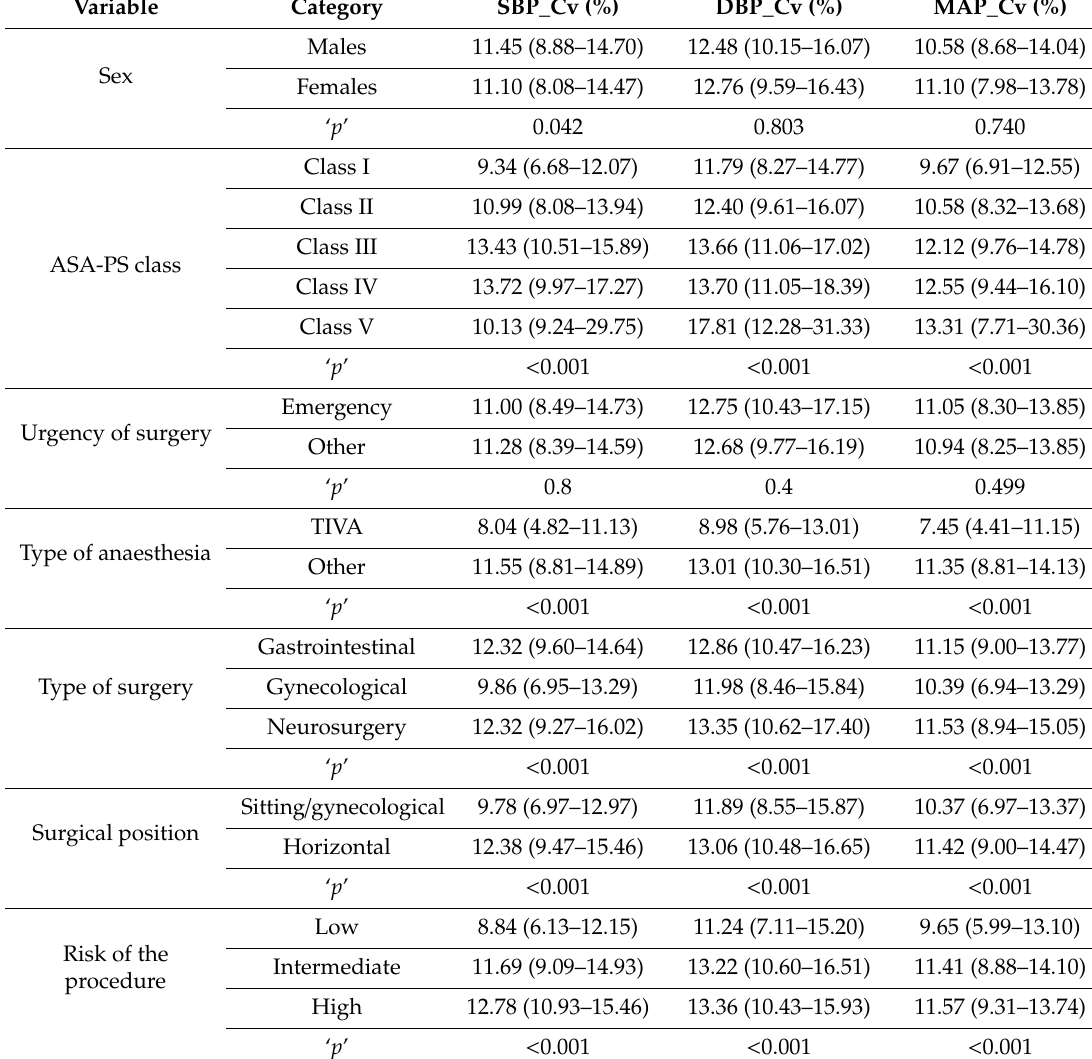
Table 2. Blood pressure variability in categories defined by the patient- and procedure-related variables